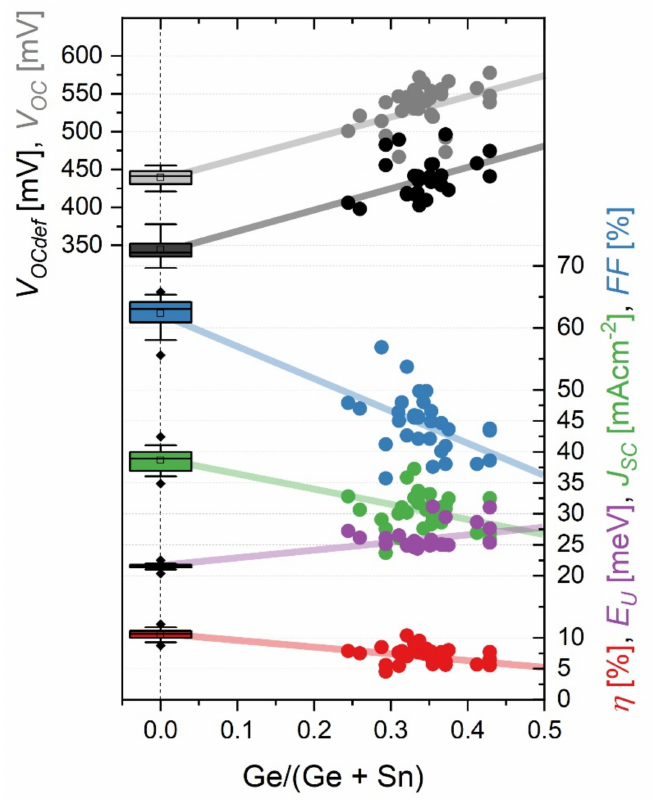
Figure 5. Device properties for CZTGSe-based solar cells with varying Ge content: V OC and V OC deficit, calculated relative to the Shockley-Queisser limit on the left axis; ï , E U , J SC and FF on the right axis. Trend lines provided as a guide for the